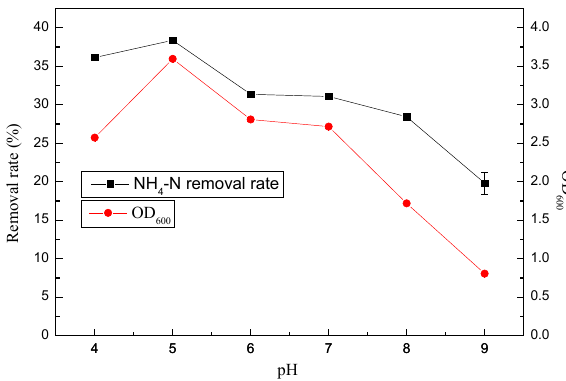
Figure 6: The effect of pH of ammonium nitrogen removal and OD by strain